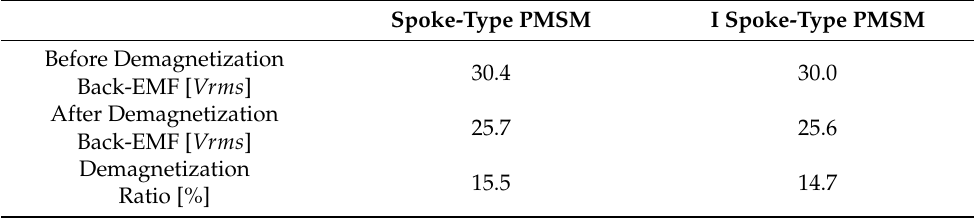
Figure 16. Comparison of Back-EMF before and after irreversible demagnetization. ( a ) Spoke- type PMSM No-load Back-electromotive force, 1000 [RPM]; ( b ) I spoke-type PMSM No-load Back- electromotive force, 1000 [RPM]. Table 5. Comparison of irreversible